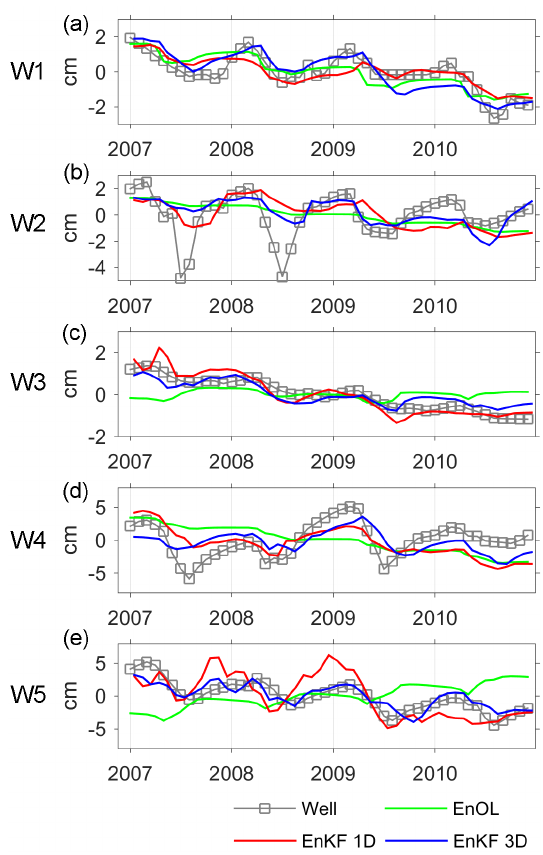
Figure 12. Monthly GWS variation estimates from the in situ well measurements, as well as EnOL, EnKF 1D, and EnKF 3D results, between January 2007 and December 2010 at five groundwater well locations. The chosen period is based on the availability of the well